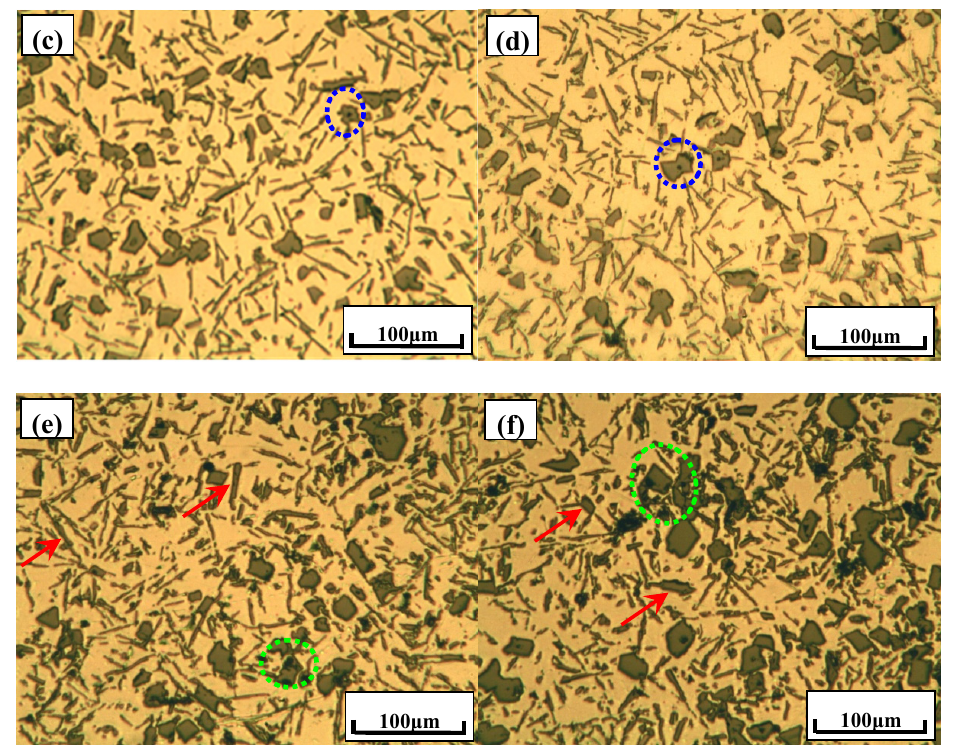
Figure 1. Typical microstructures of Al–18Si alloys with different melt treatments: ( a , b ) 0.2% Al–29Ca alloy; ( c , d ) 1.5% Al–6Y–2P master alloy; ( e , f ) 0.2% Al–29Ca; and, 1.5% Al–6Y–2P master alloys.